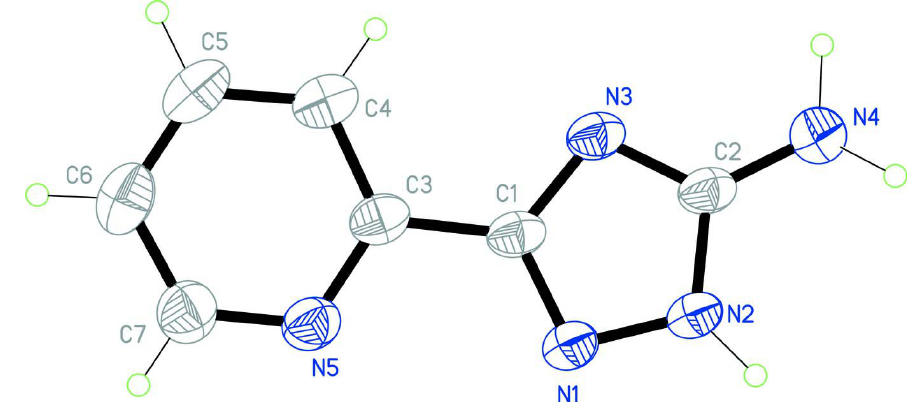
Figure 1 Possible tautomers and rotamers of 3-pyridin-2-yl-1,2,4-triazol-5-amine.